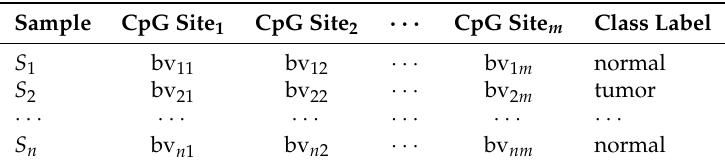
Table 2. Data matrix of DNA methylation